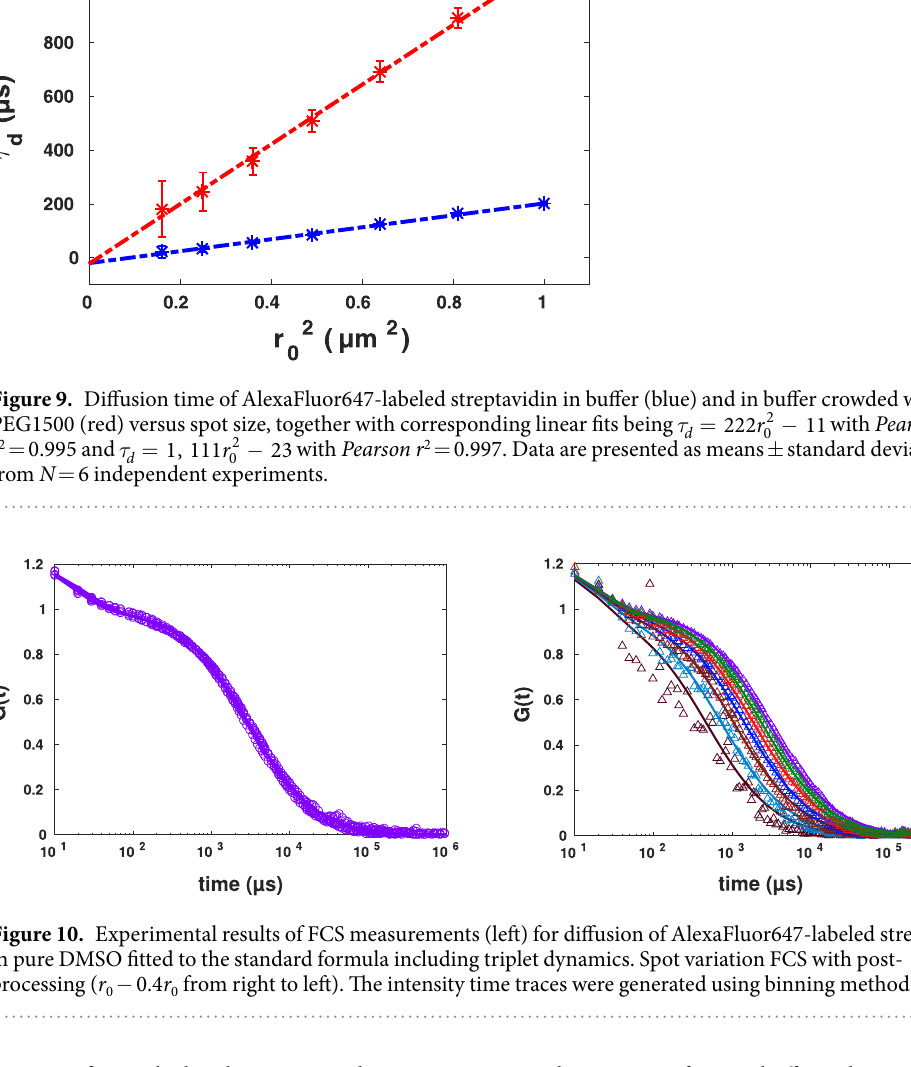
Figure 10. Experimental results of FCS measurements (left) for diffusion of AlexaFluor647-labeled streptavidin in pure DMSO fitted to the standard formula including triplet dynamics. Spot variation FCS with post- processing ( r 0 − 0.4 r 0 from right to left). The intensity time traces were generated using binning method